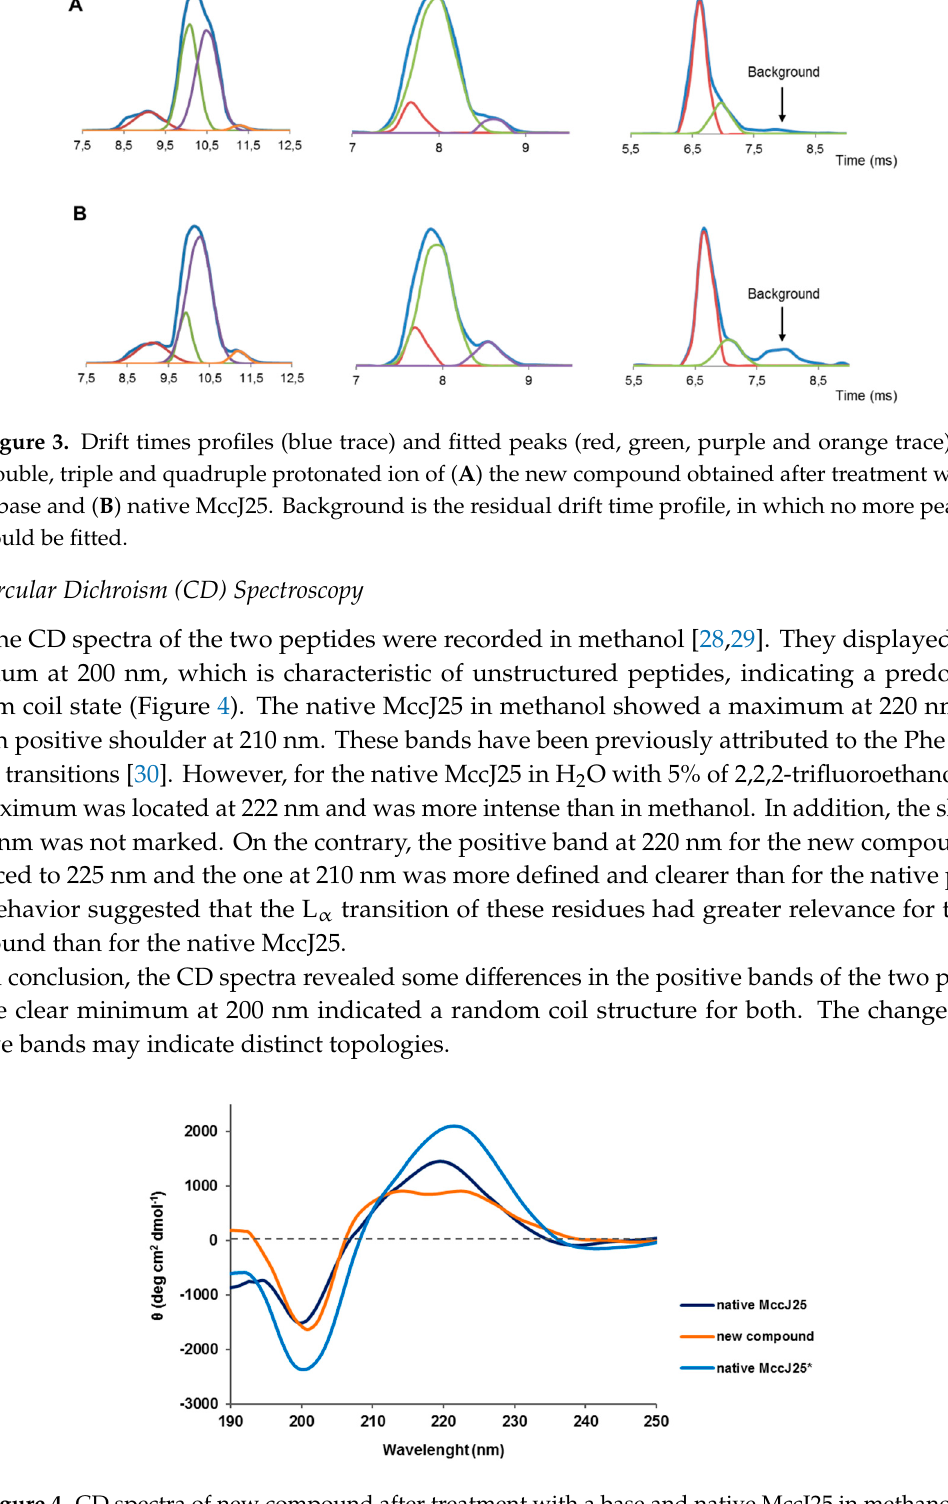
Figure 4. CD spectra of new compound after treatment with a base and native MccJ25 in methanol. * in H 2 O with 5% TFE.